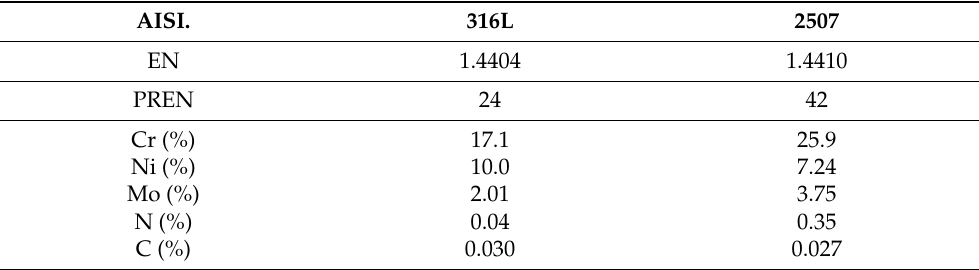
Table 1. Composition and pitting resistance equivalent numbers (PRENs) of the 316L and 2507 grade stainless steels.